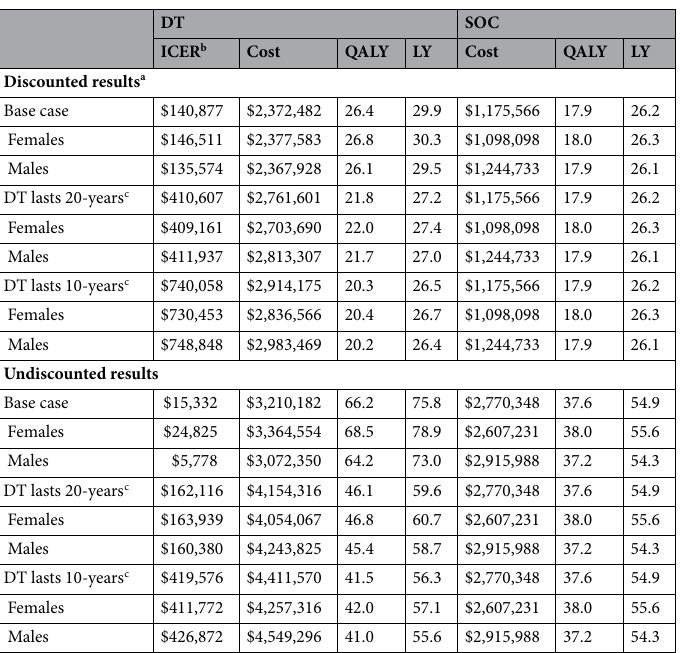
Table 2. Discounted and undiscounted base case and scenario analysis results, per-patient. DT durable therapy, SOC standard of care, ICER incremental cost-effectiveness ratio, QALY quality-adjusted life year, LY life year. a All outcomes discounted at 3% per year. b ICER units are 2018 US dollars per QALY. c Expected median